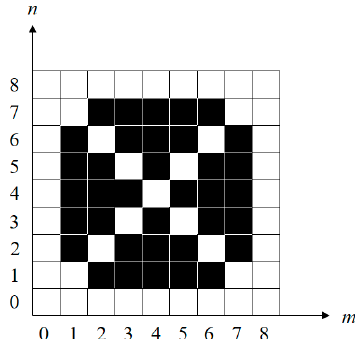
Figure 1. An example of the grid-cross down-sampling lattice for τ = 8, and m , n = [ 0,8 ] . The cells in white and black, represent sampling and non-sampling points, respectively.